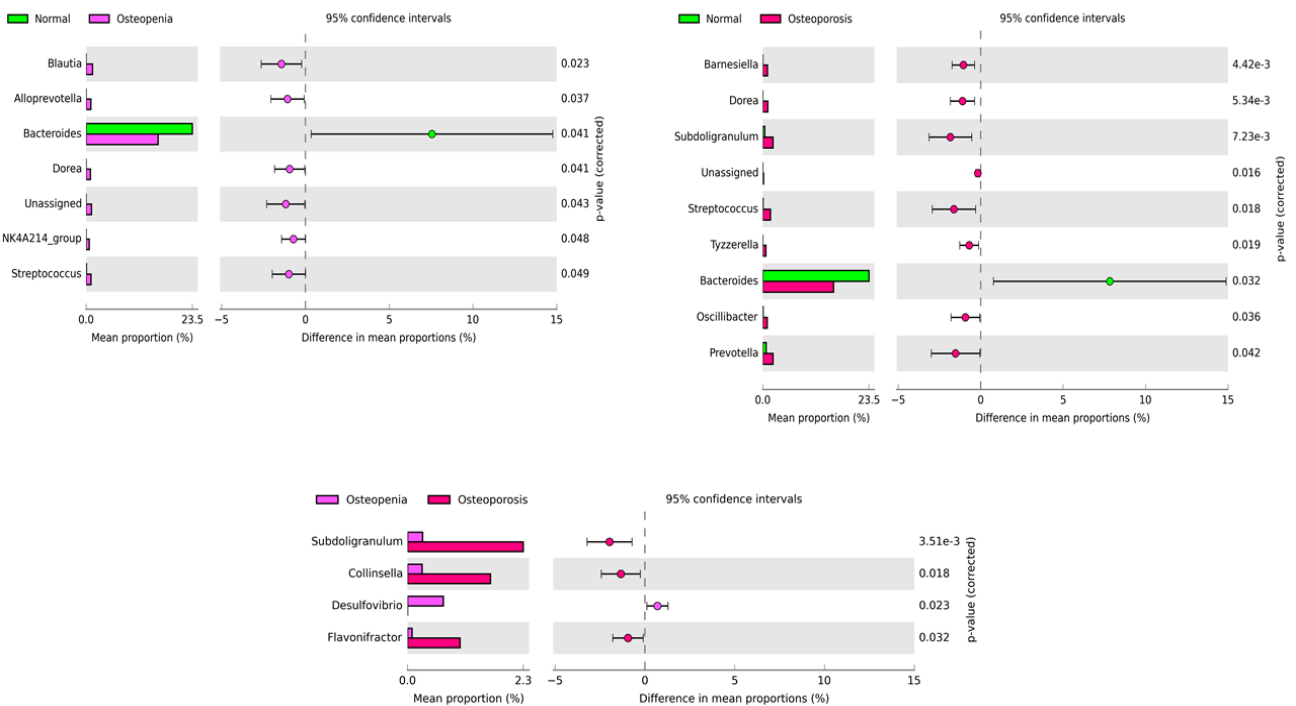
Figure 3. Enriched bacterial genera based on 16S rRNA among the experimental group. The left panel of each figure shows the bacterial abundance of differentially enriched genera. The right panel represents the significant difference at p < 0.05. The middle panel indicates the mean proportion of differentially enriched bacterial genera at a 95% confidence interval.